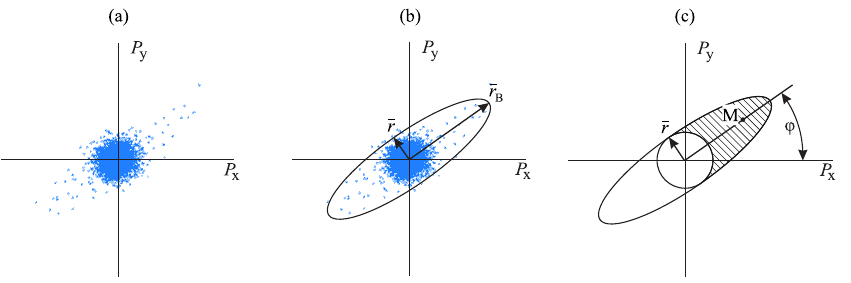
Figure 11. Example of AE pulse: ( a ) pulse; ( b ) hodograph of acoustic pressure gradient represented in three-dimensional coordinates with the projections on axial planes. In the figure, X, Y and Z are coordinate axes.